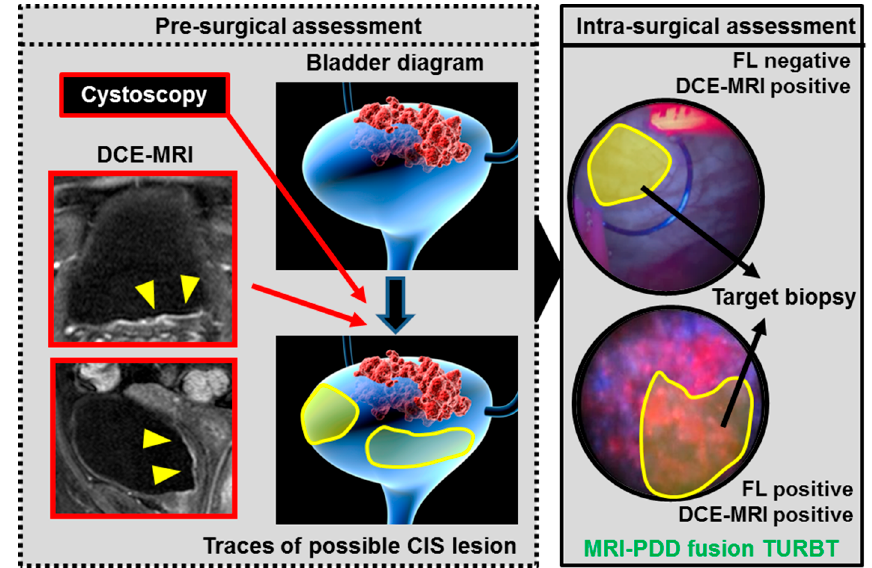
Figure 4. The concept of future ‘MRI-PDD fusion TURBT’. MRI-PDD fusion TURBT consists of two steps: pre-surgical assessment and intra-surgical assessment. The pre-surgical assessment requires a cystoscopic examination and DCE-MRI. During these imaging tests, the same volume of saline (for example 200 mL) is stored in the bladder through the catheter. The three-dimensional bladder diagram is reconstructed with the imaging results (red arrows). Yellow shade indicates bladder lesions suspected to be CIS based on the DCE-MRI. Surgeons need to have an informative image regarding the bladder shape and malignant lesions before the endoscopic surgery. During the surgery, the FL source provides additional information for the papillary and flat bladder lesions, especially CIS (intra-surgical assessment). The MRI-PDD fusion imaging is shown in the surgical monitor during TURBT, enabling the target biopsy for detecting CIS (black arrows).